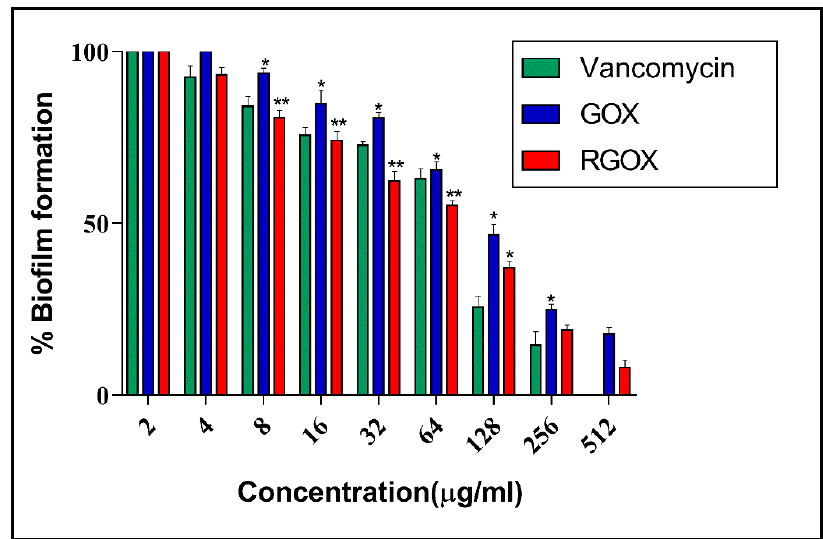
Figure 7. GOX and RGOX effect against S. aureus biofilm development. An increasing concentration of compounds decreases the percentage of biofilm formation. Vancomycin served as a control (p-value < 0.05 *, < 0.01 ** and < 0.001 ***).